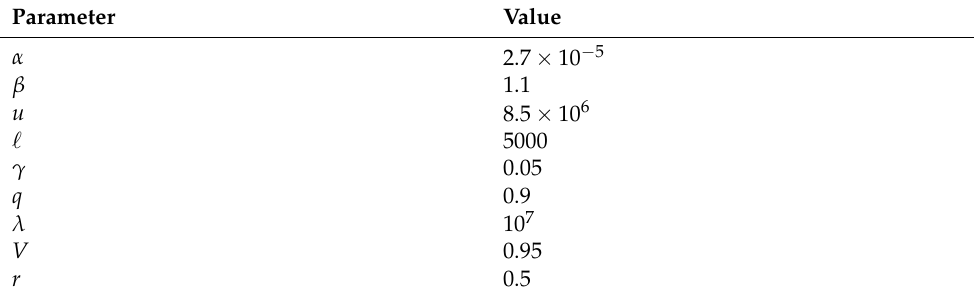
Table 1. Values of the parameters